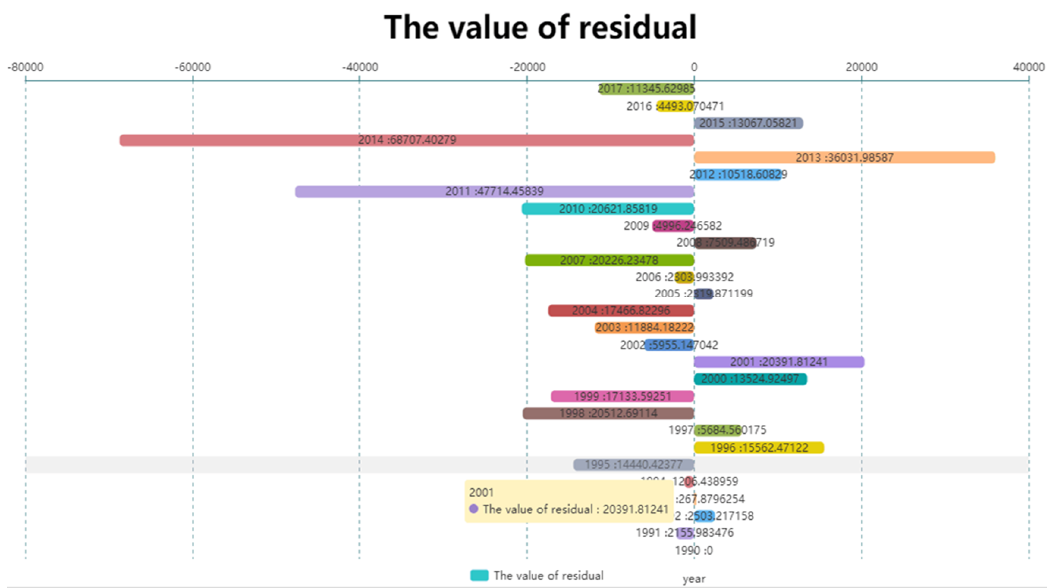
Figure 17. The value of residual.